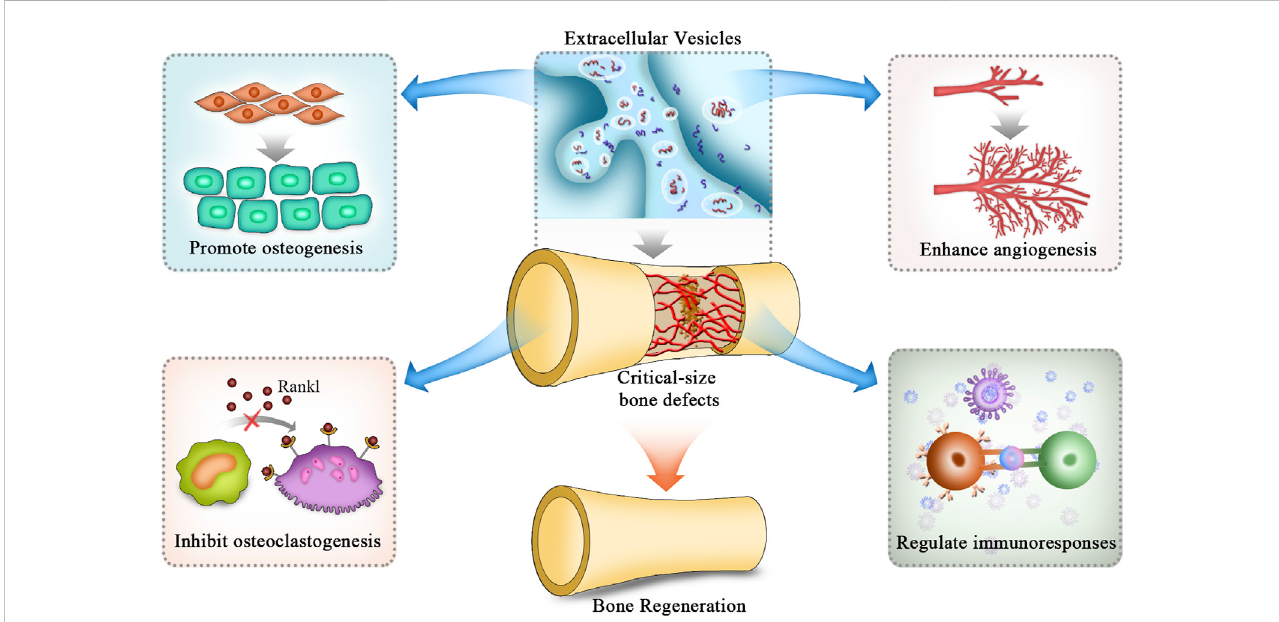
FIGURE 2 MechanismsofEVsappliedinBTEtorepaircritical-sizebonedefects.ThemechanismsofEVsinrepairingcritical-sizebonedefectsaremainlyattributed to the promotion of osteogenic differentiation of stromal cells while inhibiting the differentiation of osteoclasts. In addition, they also promote angiogenesis and modulate in fl ammatory responses to provide a suitable environment for bone regeneration. EVs: extracellular